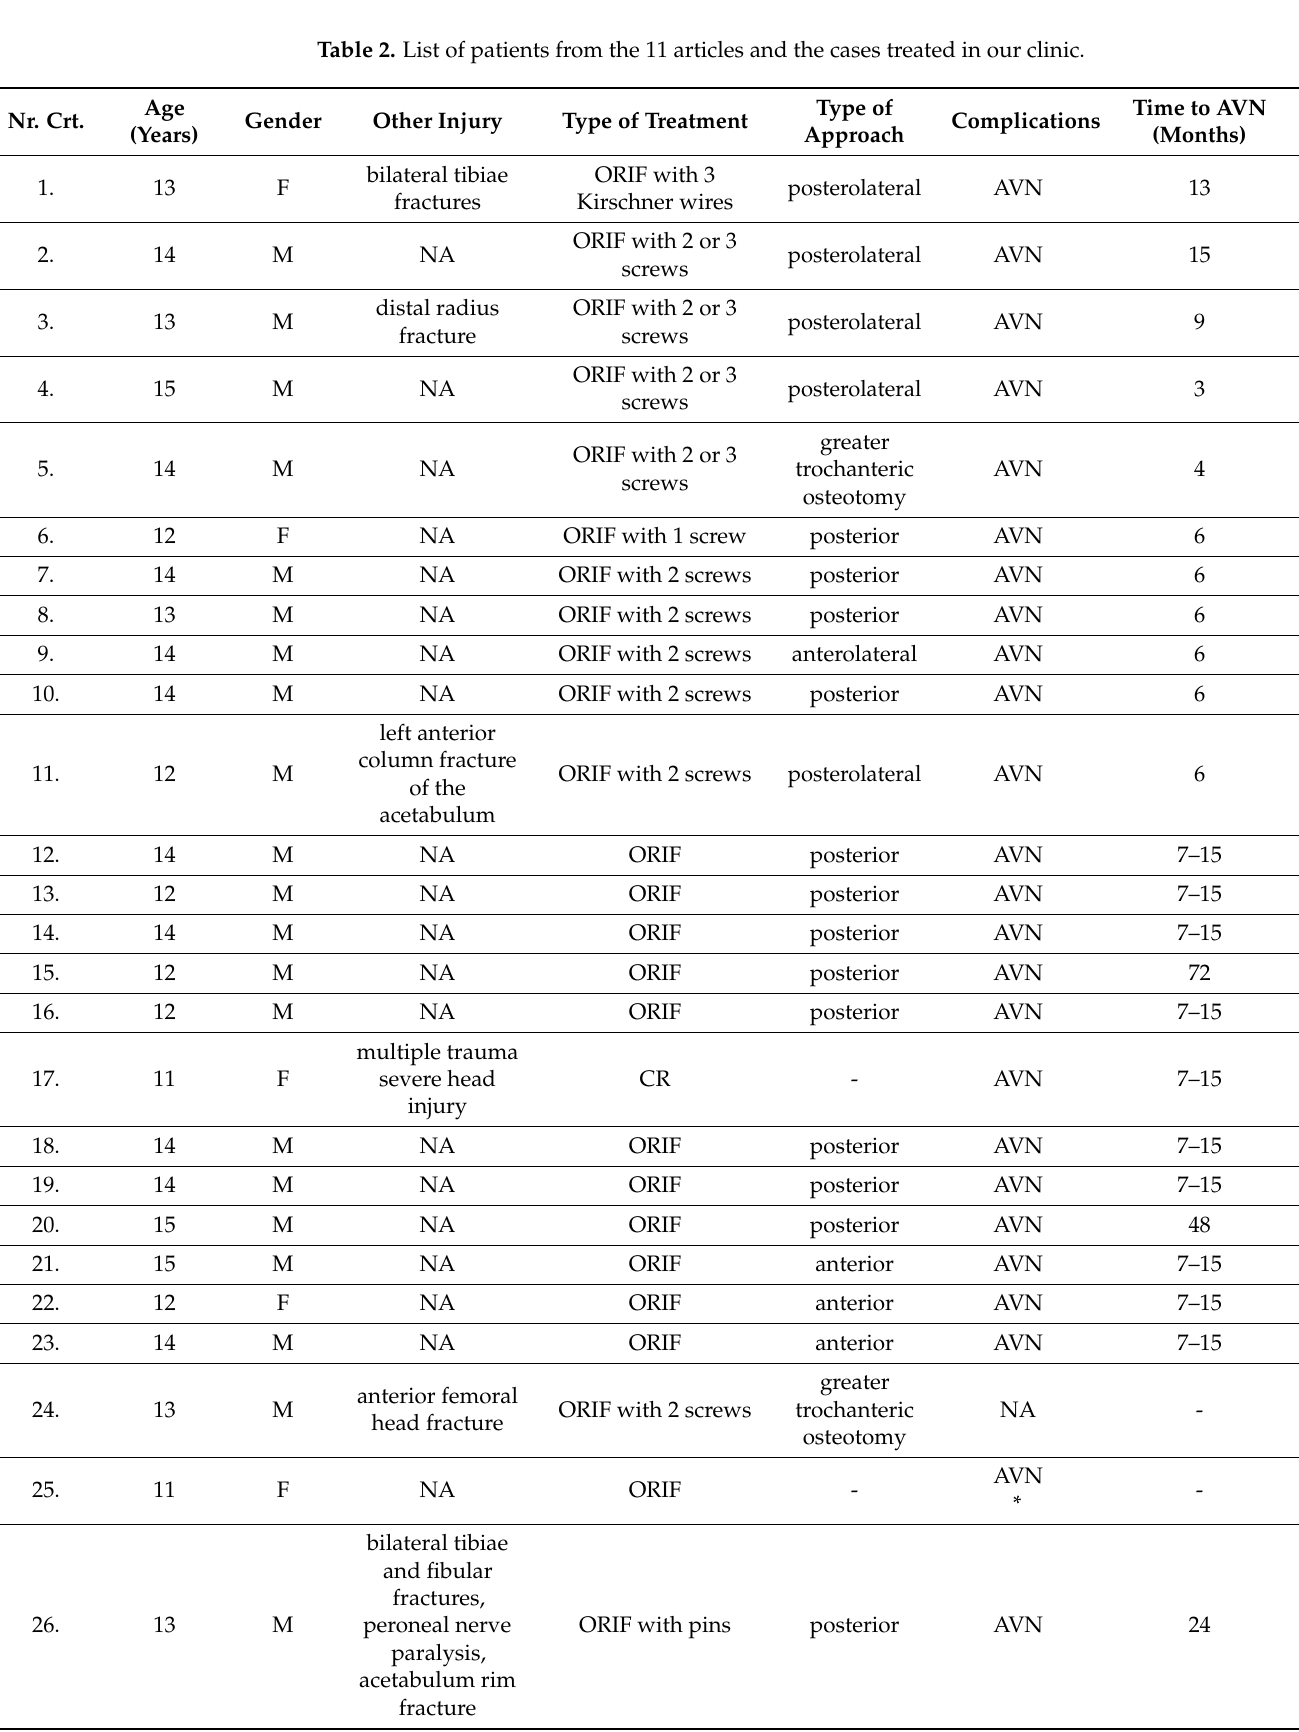
Table 2. List of patients from the 11 articles and the cases treated in our